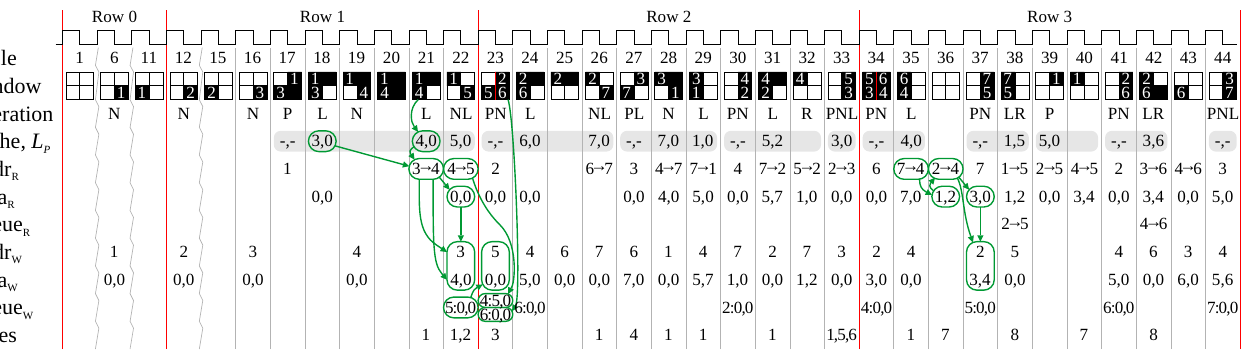
Figure 7. Memory accesses when processing the example image of Figure 6. Note that some cycles at the start (where nothing interesting is happening) are skipped. Notes: 1 . A chain operation updates the cache, and adds the chained link to memory. 2 . The N-operation is queued because the write port is busy (rule 9). 3 . Two additional writes are initiated (one from the previous chained link, and one for the new index), both are queued. 4 . The L-operation must be delayed because the cache has not been loaded yet (rule 3). 5 . The previous read is used to initialise the cache for the P-operation (rule 5). 6 . Since this is the last pixel in the row, an L-operation also started in this cycle. 7 . The node already has two links, so the link must be passed on (rule 7). 8 . Both an L- and R-operation are initiated this cycle; the retirement link is processed first and the chain queued (rule